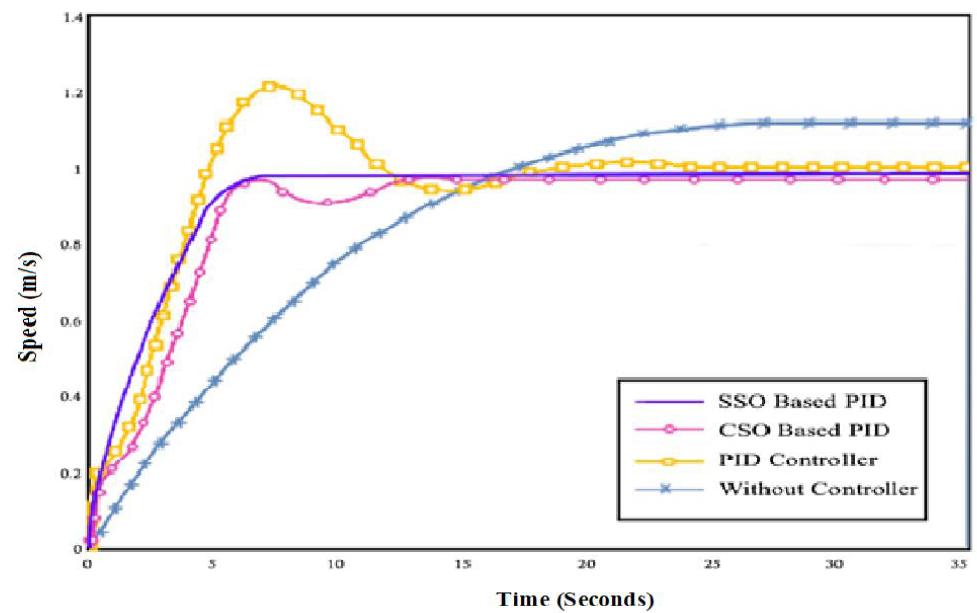
Figure 8. Comparison of closed-loop response of DC motor 2 in SSO, CSO, PID controller, and without controller.